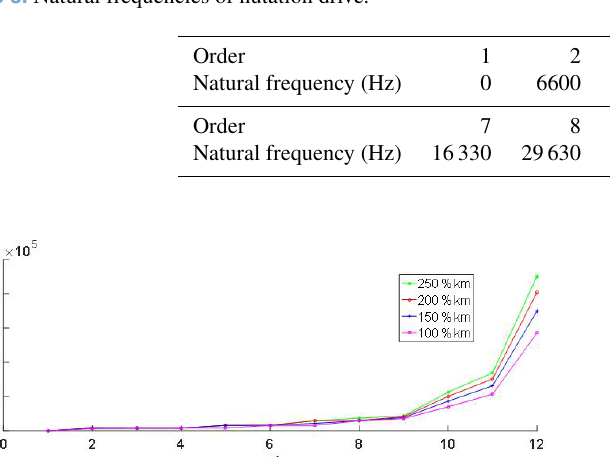
Figure 4. Modal shape of each order natural frequency. Table 3. Natural frequencies of nutation drive.